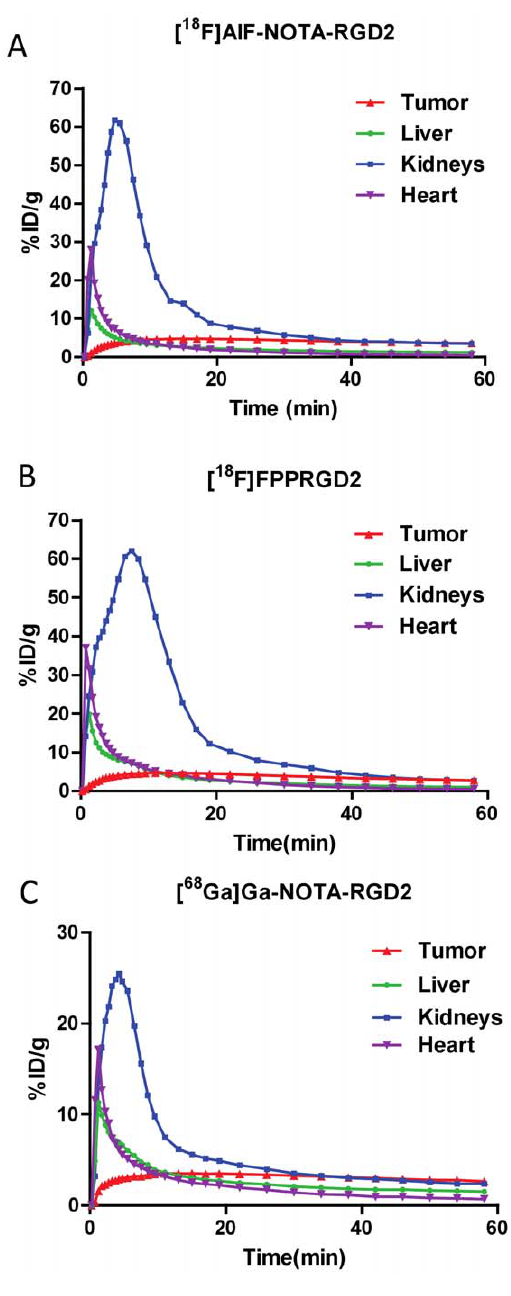
(kidneys, heart, tumor and liver) derived from 60-min dynamic PET scans after administration of dimeric RGD peptide tracers. ( a ) [ 18 F]AlF-NOTA-PRGD2, ( b ) [ 18 F]FPPRGD2, and ( c ) [ 68 Ga]Ga-NOTA- PRGD2 (n=4/group).